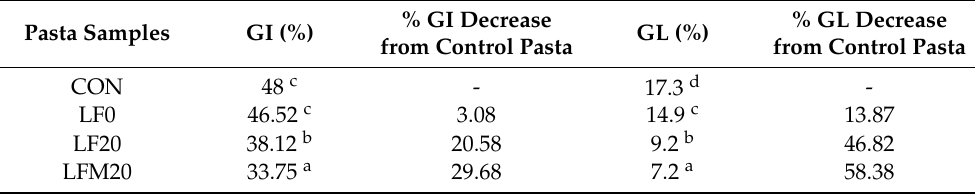
% GI Decrease % GL Decrease GL (%) from Control Pasta from Control Pasta